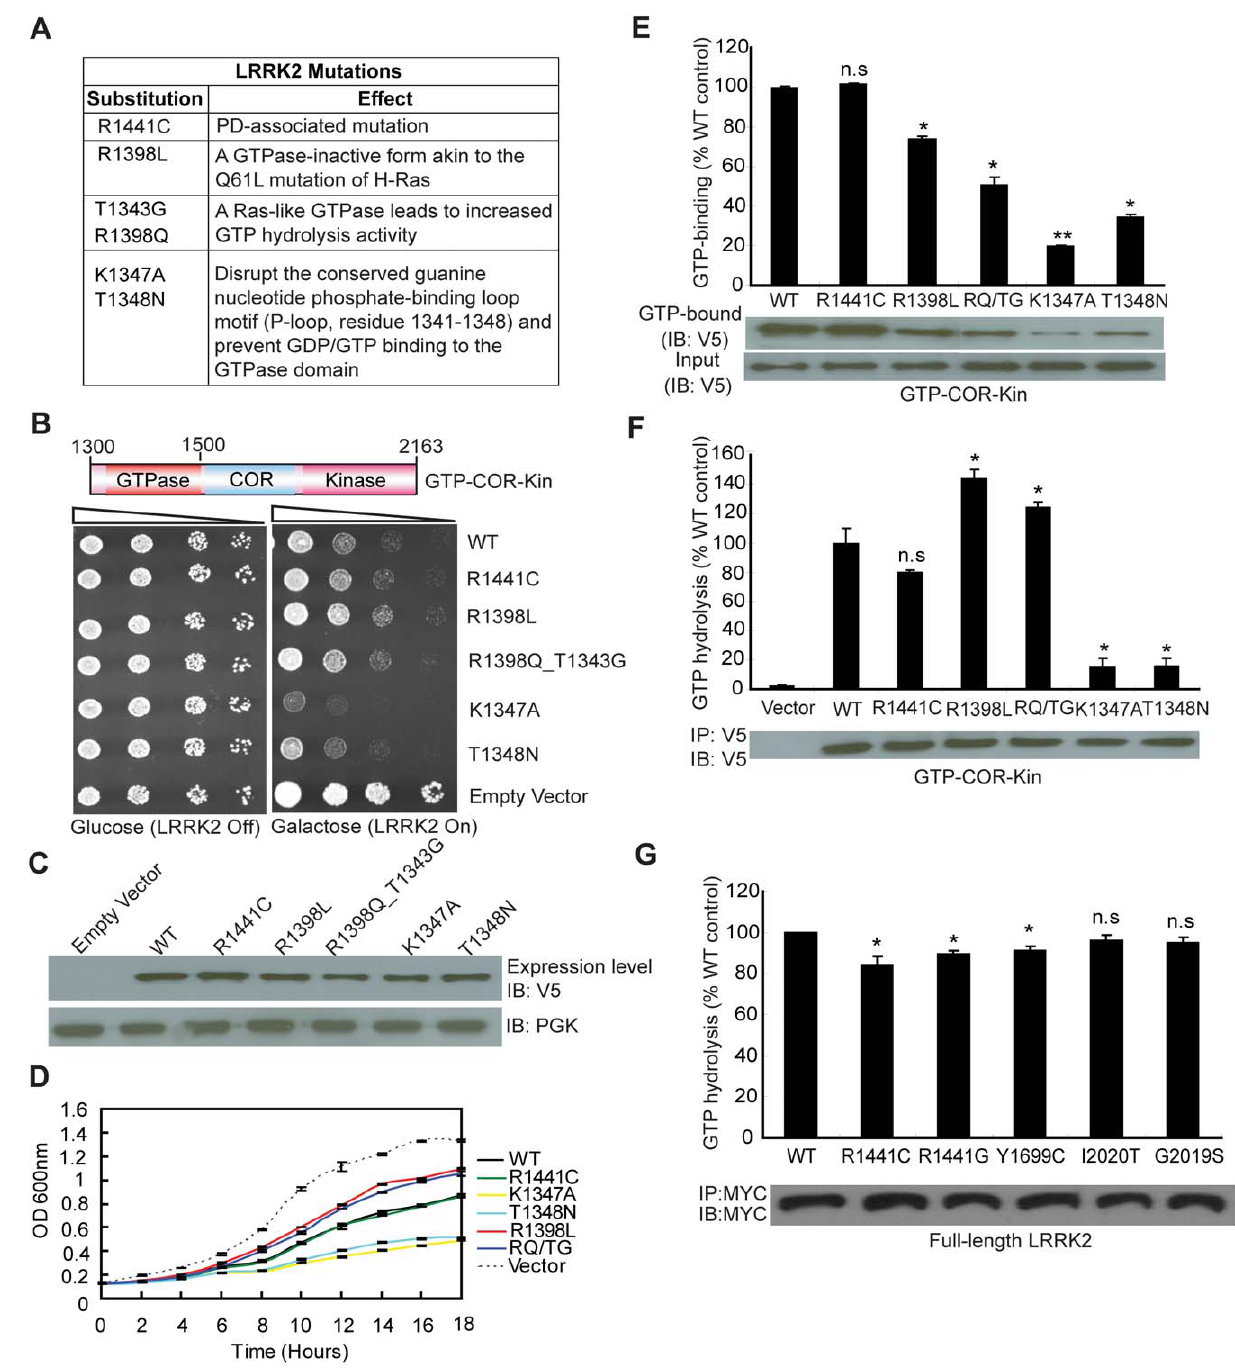
Figure 2. GTPase activity modulates LRRK2-induced toxicity in yeast. (A) Table of LRRK2 sequence variants employed in this study and their predicted functional effects. (B) GTPase mutations, K1347A and T1348N, markedly enhance LRRK2-induced toxicity in yeast compared to WT or other GTPase mutations. Yeast cells were transformed with galactose-inducible expression constructs containing the central GTP-COR-Kin fragment of LRRK2 harboring various functional GTPase variants (WT, R1441C, R1398L, R1398Q/T1343G, K1347A, and T1348N) or empty vector as a control. Spotting experiments were conducted to examine the viability of yeast cells due to the expression of each truncated LRRK2 GTPase variant. Shown are five-fold serial dilutions (from left to right, as indicated by graded open box) starting with equal numbers of cells grown on media containing glucose (LRRK2 Off, left panel) or galactose (LRRK2 On, right panel). (C) Expression of LRRK2 GTPase variants in the GTP-COR-Kin fragment in yeast following galactose induction was detected by Western blot analysis with anti-V5 antibody, with anti-PGK antibody as control for protein loading. (D) Growth curve analysis in liquid media containing galactose was used to measure the growth rate of yeast cells expressing each truncated LRRK2 GTPase variant relative to an empty vector control. Data are taken from three independent experiments with each data point representing the mean 6 SEM ( n =3). (E) GTP-binding activity was determined for each LRRK2 GTPase variant (in the GTP-COR-Kin fragment) derived from yeast cell lysates following galactose induction by measuring the relative levels of GTP-bound LRRK2 with normalization to input levels of total LRRK2. LRRK2 levels